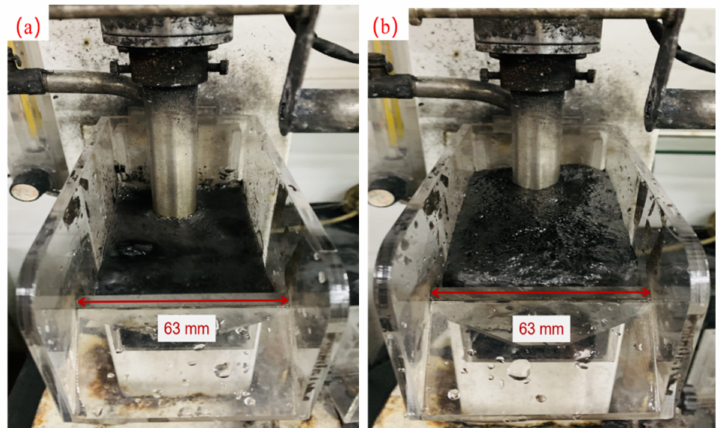
Figure 15. Side-view photos of froth produced in the presence of ( a ) kerosene and ( b ) emulsified kerosene. For conventional flotation (kerosene+ sec-Octyl alcohol), the collector and frother dosages were 500 g/t kerosene and 167 g/t sec-Octyl alcohol, respectively. For the mixture reagent (emulsified kerosene), the equivalent kerosene dosage was also kept as 500 g/t as a control